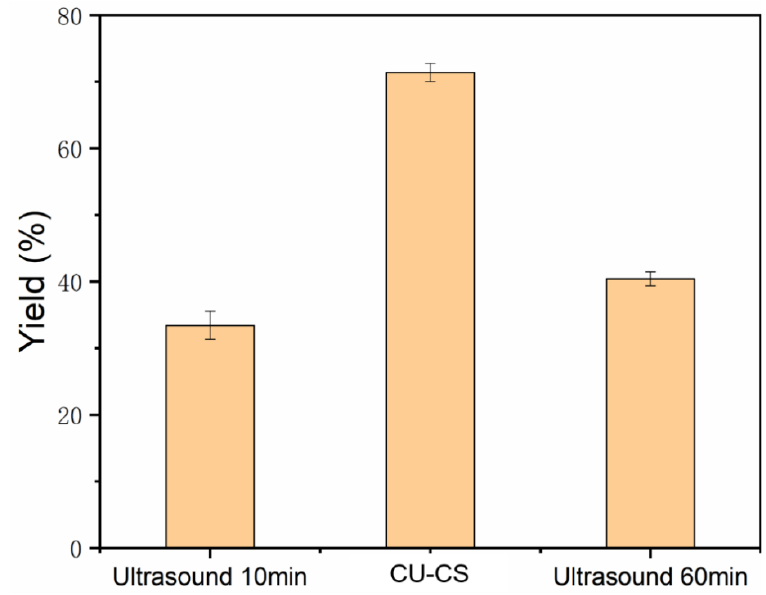
Figure 5. The AFM images of CU-CS Ti 3 C 2 T x MXene: ( a ) 1, ( b )2, ( c ) 3, ( d ) 4, ( e ) 5 and ( f ) 6.